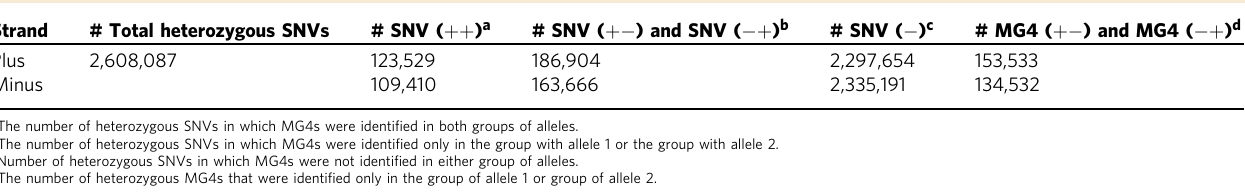
Table 3 The in fl uence of heterozygous SNVs on MG4 detection.